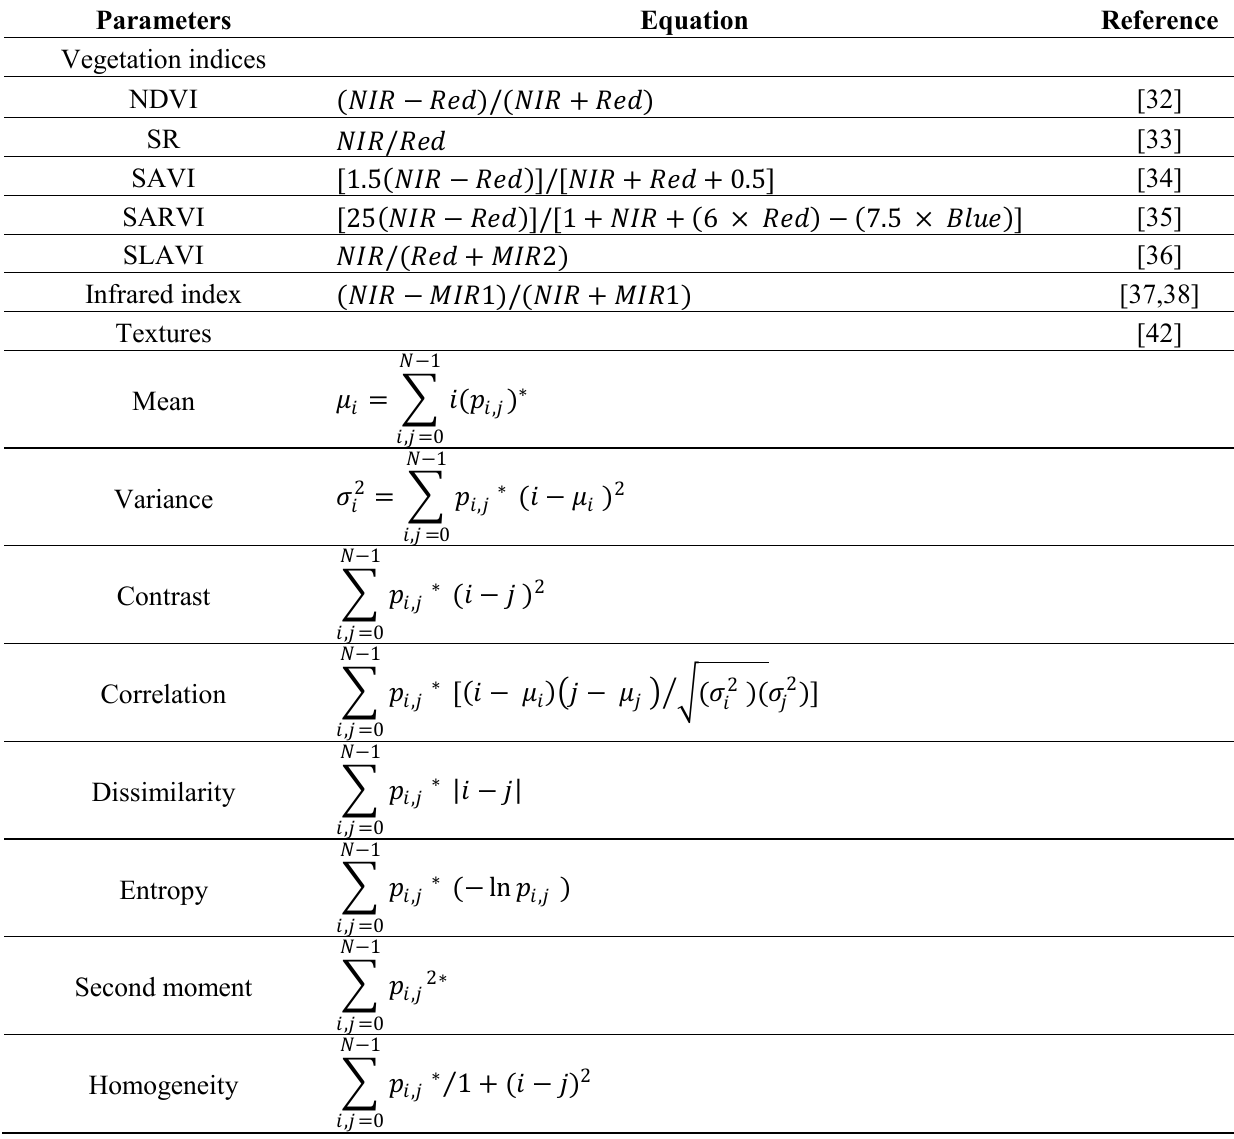
Table 3. Vegetation indices and GLCM